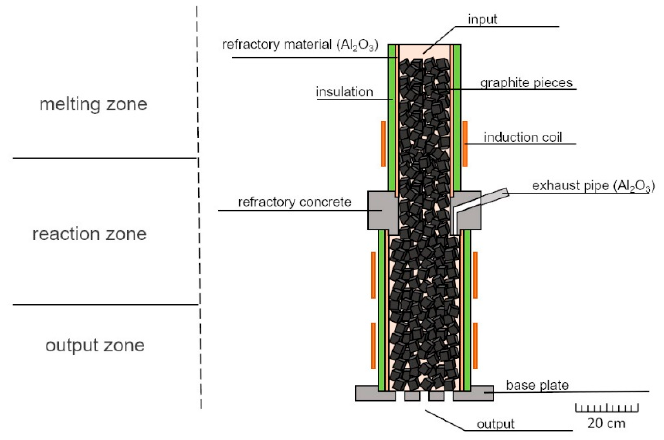
Figure 2. Schematic illustration of the InduRed reactor for the continuous treatment of sewage sludge ashes and BOFS [39].